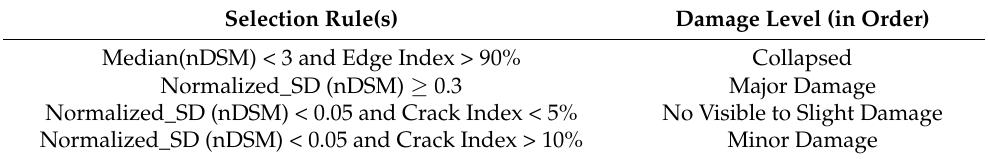
Table 4. Rules for automated selection of training